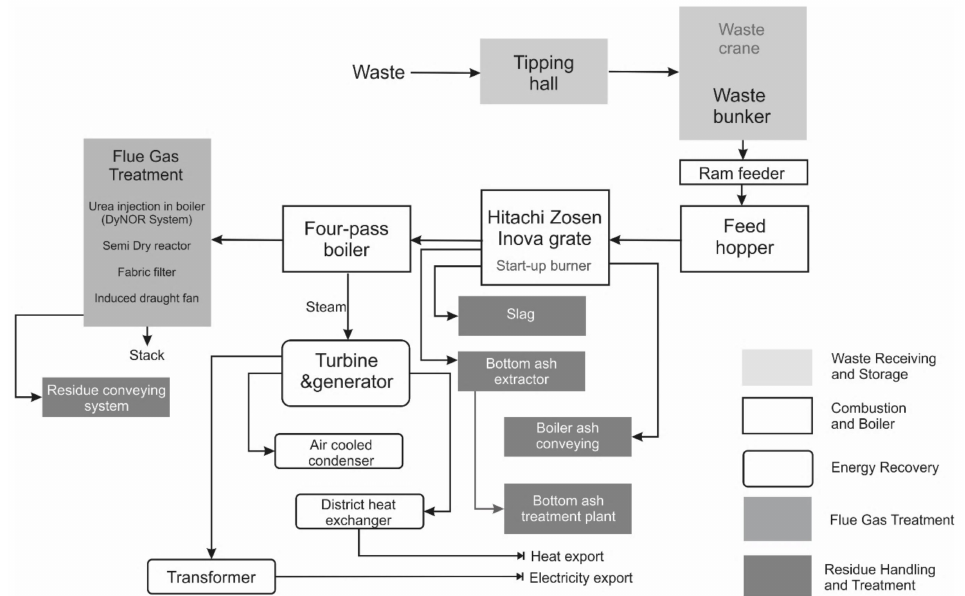
Figure 2. Simplified scheme of an analyzed municipal solid waste (MSW) incinerator (author: M. Czop based on